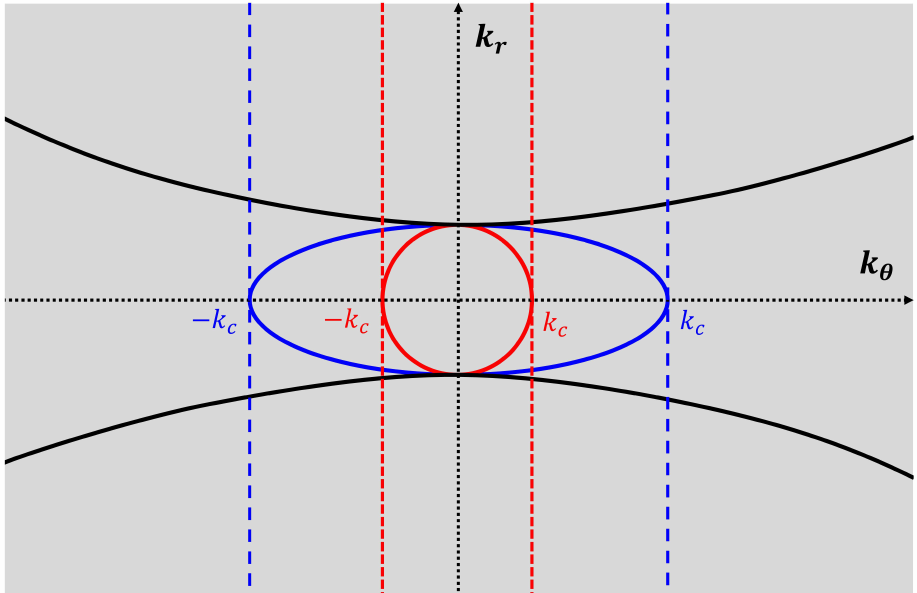
Figure 5. Schematics of spherical EFCs (red solid line), elliptic EFCs (blue solid line) and hyperbolic EFCs (black solid line). Red broken line: an unbounded area of spherical EFCs. Blue broken line: an unbounded area of elliptic EFCs. Red k c and − k c : cutoff wavevectors of spherical EFCs. Blue k c and − k c : cutoff wavevectors of elliptic